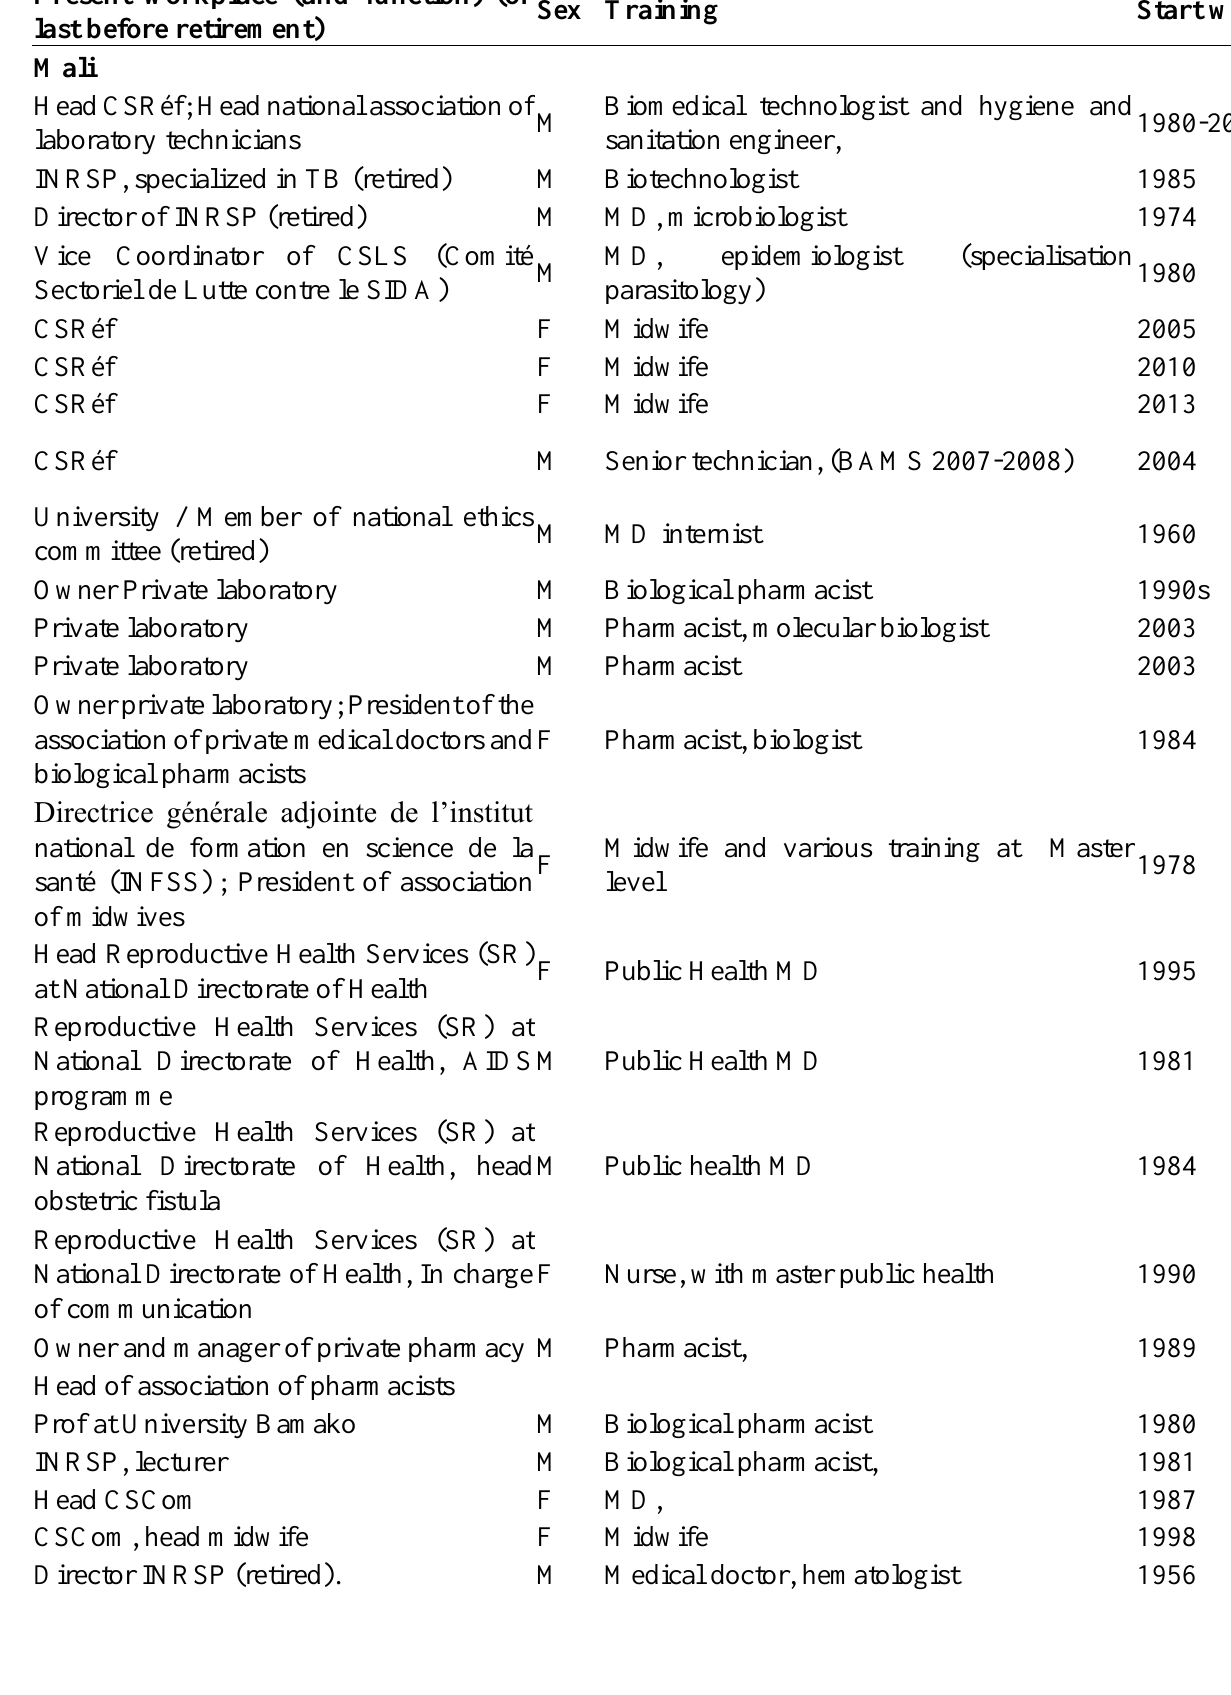
Supplementary TABLE 2: Background of the 73 key informants Present workplace (and function) (or last before